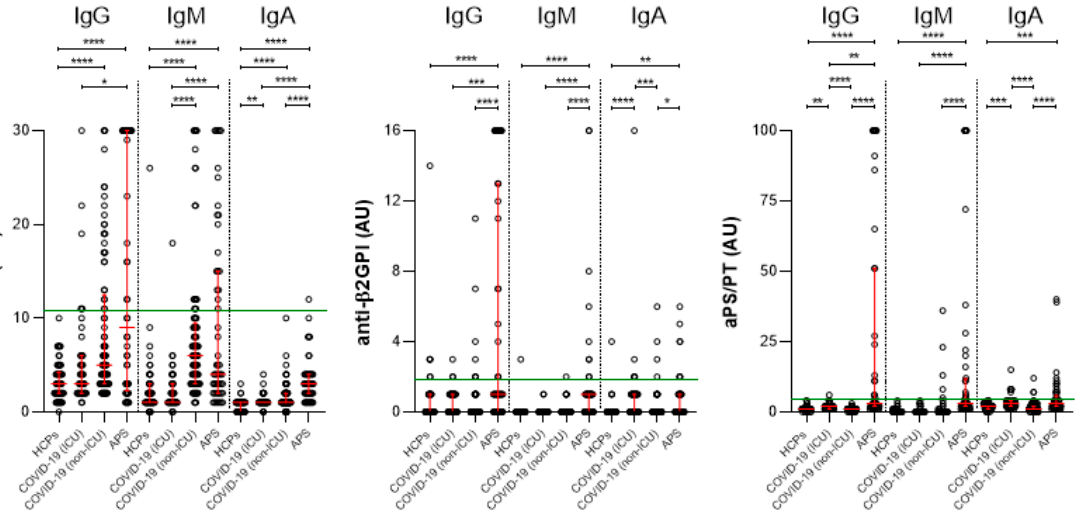
Figure 3. Levels of aCL, anti- β 2GPI, and aPS/PT, IgG, IgM, and IgA in HCPs after vaccination (group I), COVID-19 patients hospitalized in the ICU unit (group II), COVID-19 patients hospitalized in non-ICU (group III) (at hospital discharge), and APS patients (group IV). Legend: Kruskal–Wallis test with Dunn’s multiple comparison test were used. p -value of <0.05 was considered as statistically significant. * p < 0.05; ** p < 0.01; *** p < 0.001; **** p < 0.0001. The red lines represent the median levels and IQR. Values above the green line (99th percentile of healthy blood donors) are considered positive.